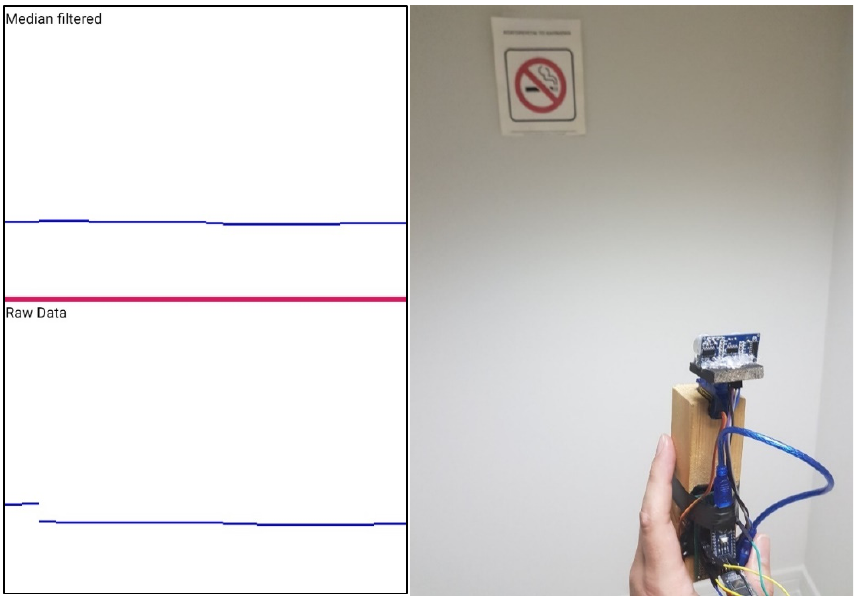
Figure 19. Measurements of the obstacle detection system facing a wall.